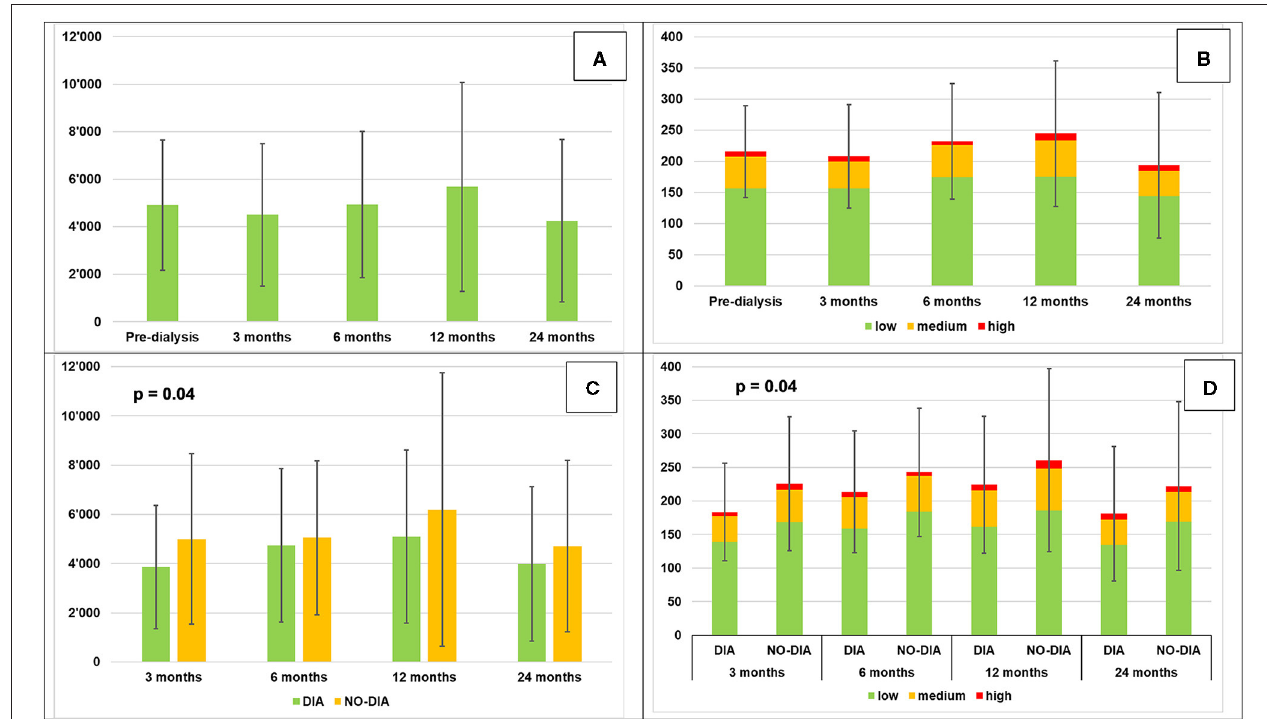
FIGURE 3 | Daily physical activity (mean ± SD). (A) Steps per day, (B) Minutes of locomotion per day at different intensities, (C) Steps per day, dialysis vs. no-dialysis days, (D) minutes of locomotion per day at different intensities: dialysis vs. no-dialysis days.